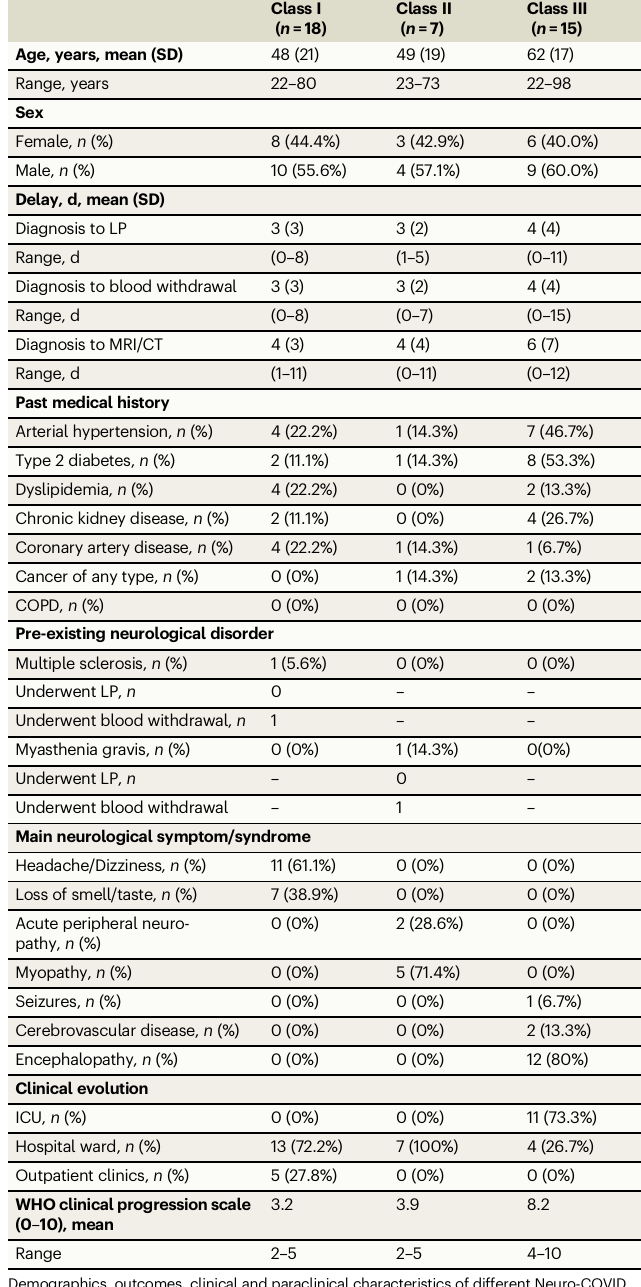
Table 1 | Characteristics of COVID-19